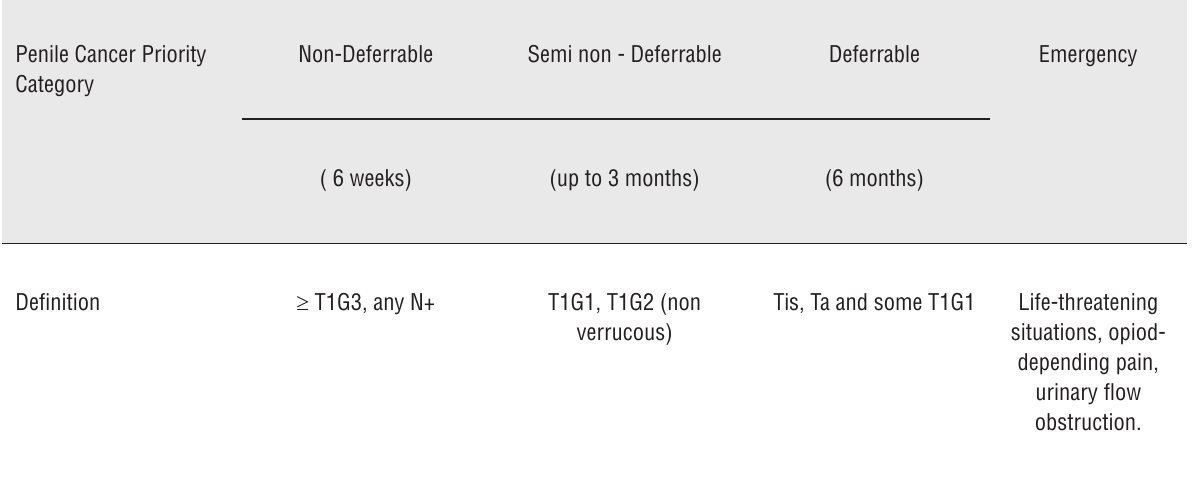
Table 1 - Treatment priority classification for Penile Cance during COVID-19 pandemic